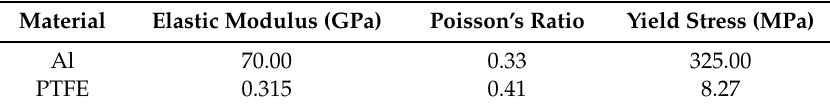
Table 2. Material properties of Al and PTFE used for simulation